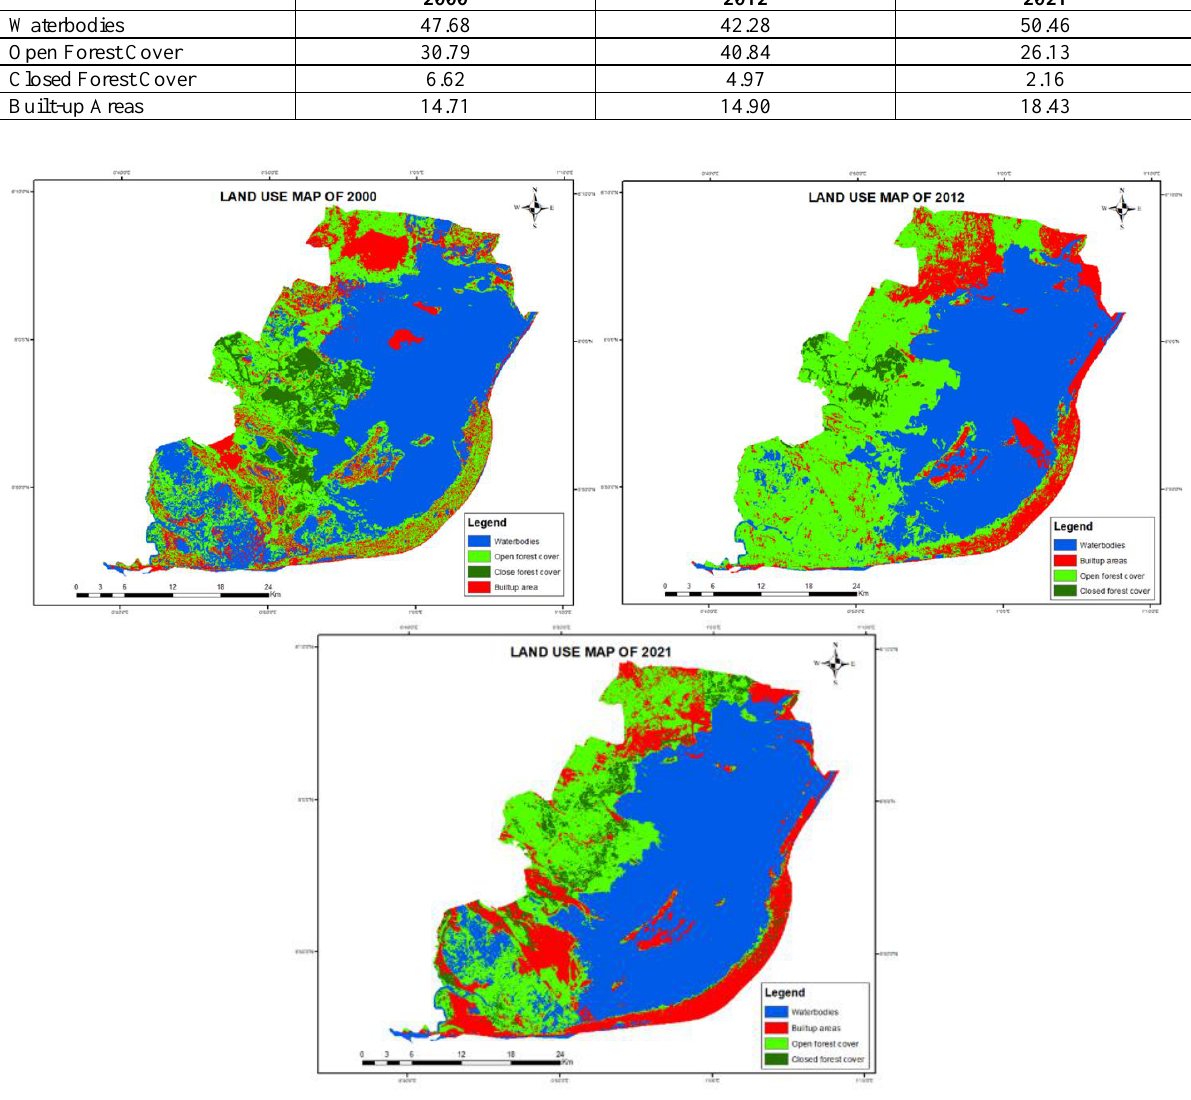
Figure 2. Land Use Land Cover